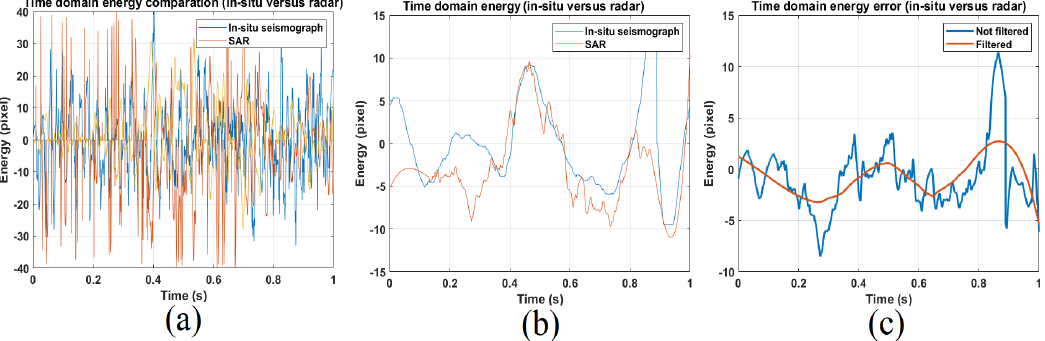
Figure 21. IV-VCRE seismograph station versus SAR synchronized time-domain vibrational stream- ing. ( a ) Native ( b ) low-pass filtered. ( c ) errors.